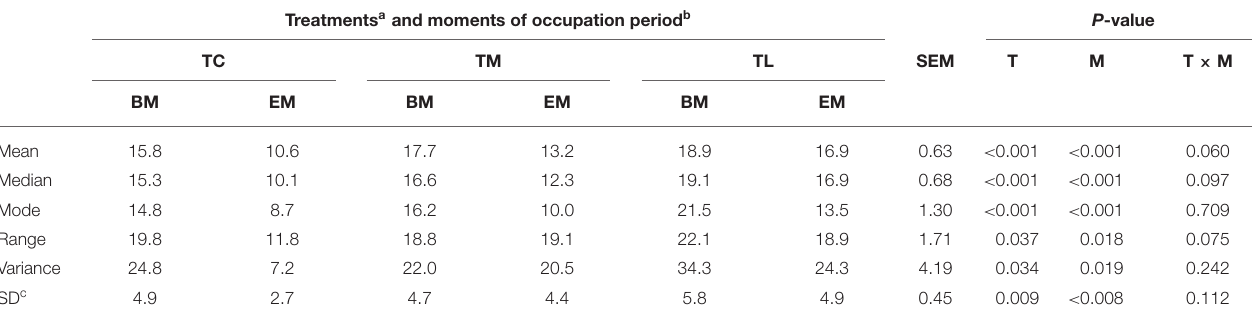
TABLE 2 | Effect of post-grazing sward height (T) and moment of occupation period (M) on sward height distribution. Treatments a and moments of occupation period b P -value